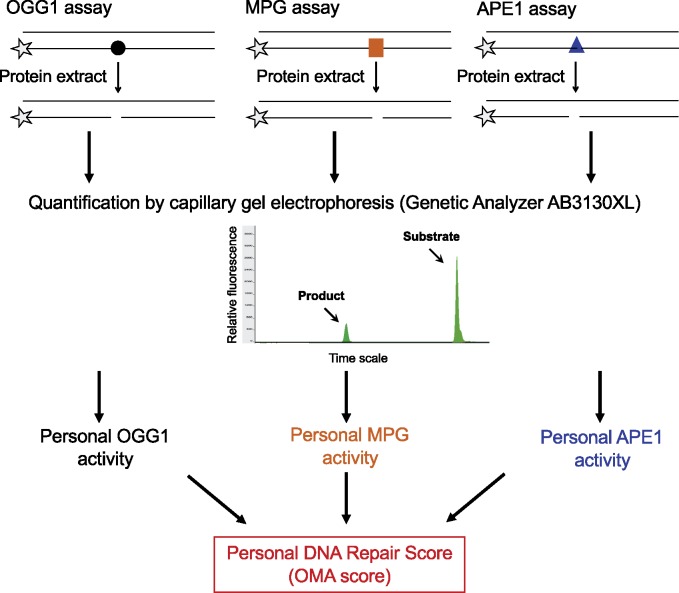
Outline of the panel of DNA Repair assays used to determine the personal DNA Repair score. Each assay measures the activity of a specific DNA Repair enzyme, in a protein extract prepared from PBMC, to remove its target DNA damage from a synthetic short oligonucleotide, shown schematically in the upper panel. Each enzyme assay was run separately under optimized conditions. The target damaged base in each substrate oligonucleotide was 8-oxoguanine in the OGG1 assay (illustrated by a black circle), hypoxanthine in the MPG assay (orange square), and a furanyl abasic site in the APE1 assay (blue triangle). The asterisks represent a 3'-Yakima Yellow fluorescence tag. Assays were run on a robotic platform and analyzed in an AB3130XL genetic analyzer. The personal OGG1, MPG, and APE1 enzyme activities were then used to calculate the personal DNA Repair score for each participant, as described in Methods. Further description of the DNA Repair assays is provided in the Supplementary Materials (available online). APE1 = apurinic/apyrimidinic endonuclease 1; MPG = methylpurine DNA glycosylase; OGG1 = 8-oxoguanine DNA glycosylase; OMA = OGG1, MPG, and APE1; PBMC = peripheral blood mononuclear cells.